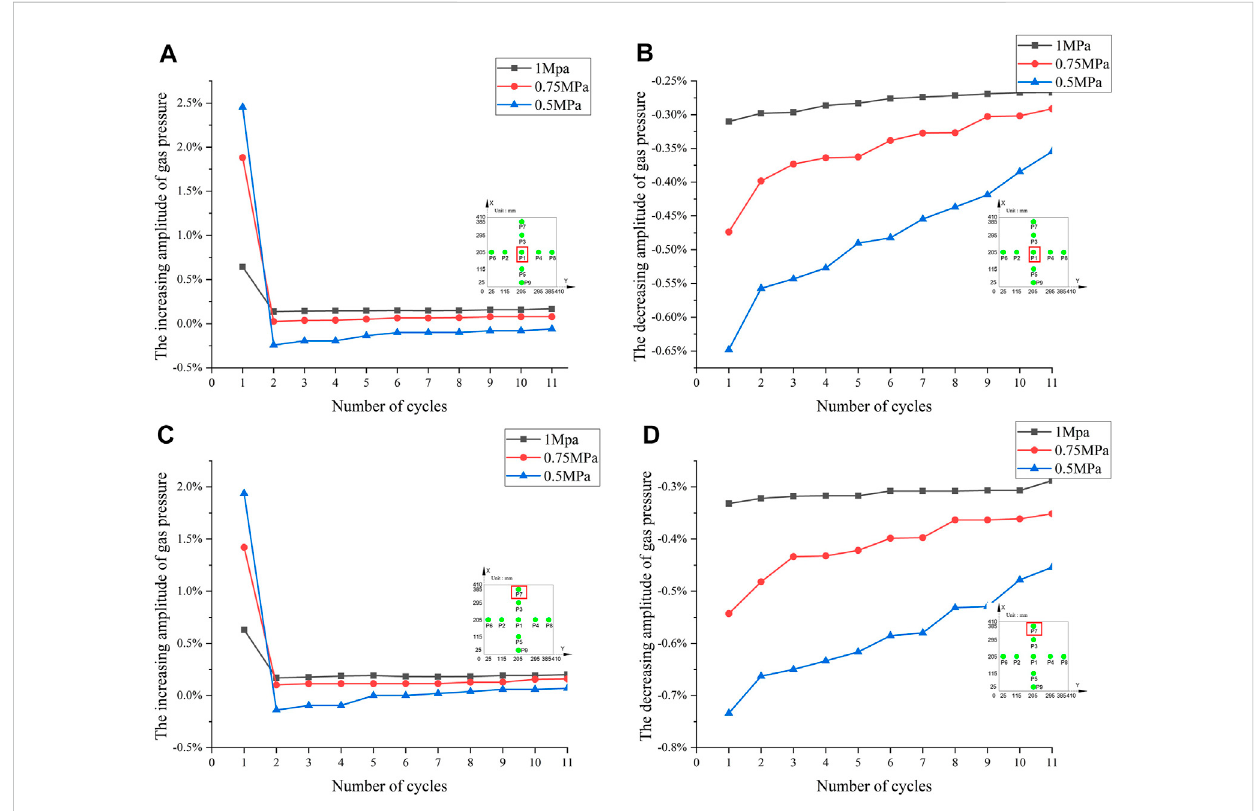
FIGURE 9 The changing law of gas pressure under different initial